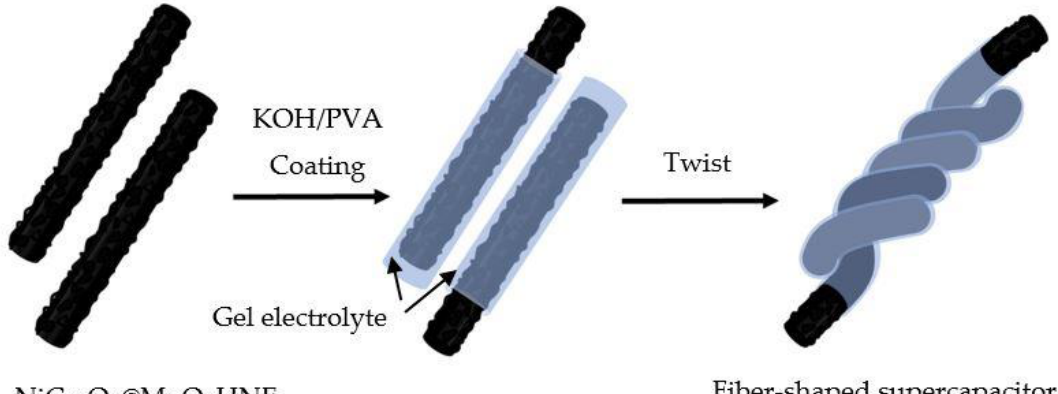
Figure 2. The assembly process of the fiber-shaped supercapacitor using KOH / PVA (polyvinyl alcohol) gel electrolyte. HNE: hierarchical nanostructured